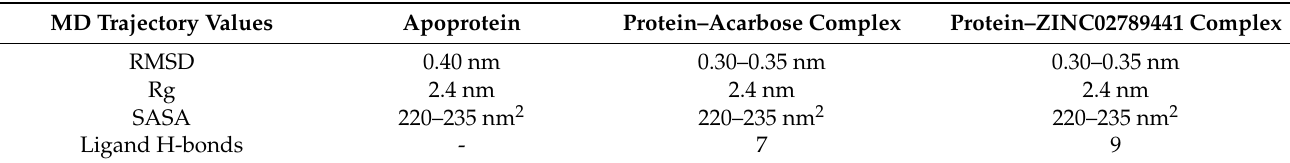
Table 8. MD trajectory values obtained for ZINC02789441 and acarbose complexed with α - glucosidase.